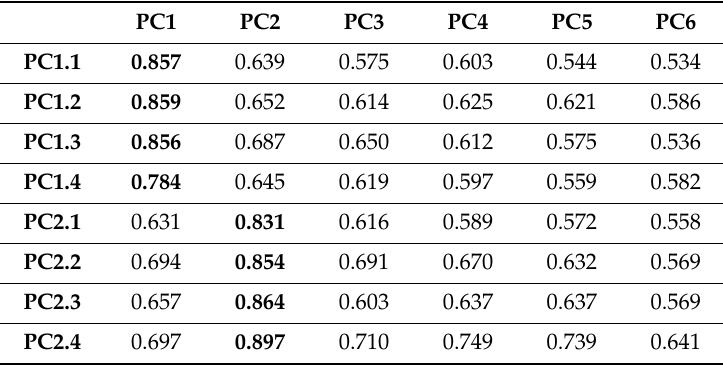
Table 8. Indicator loading and cross loading of project outcome